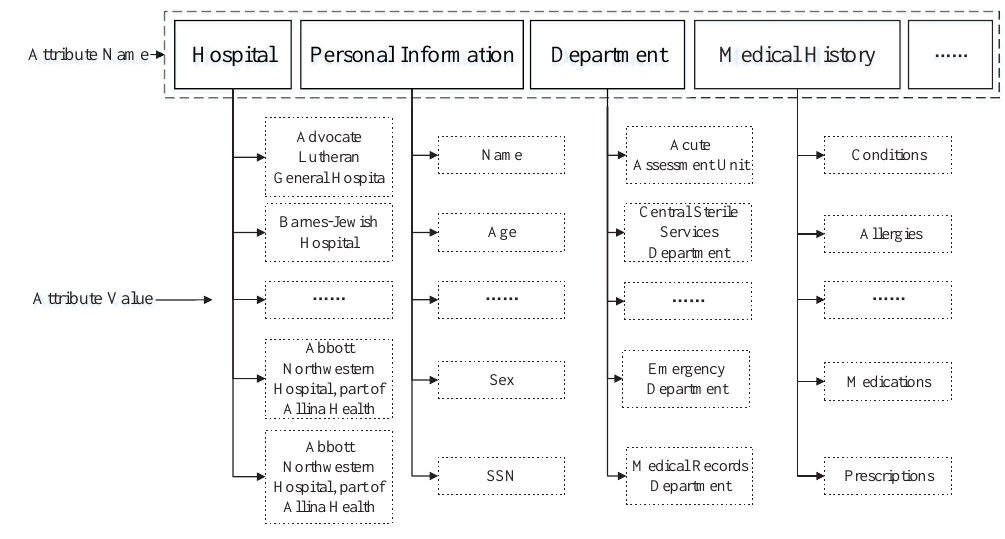
Figure 3. The attribute names and values of personal health information (PHI).